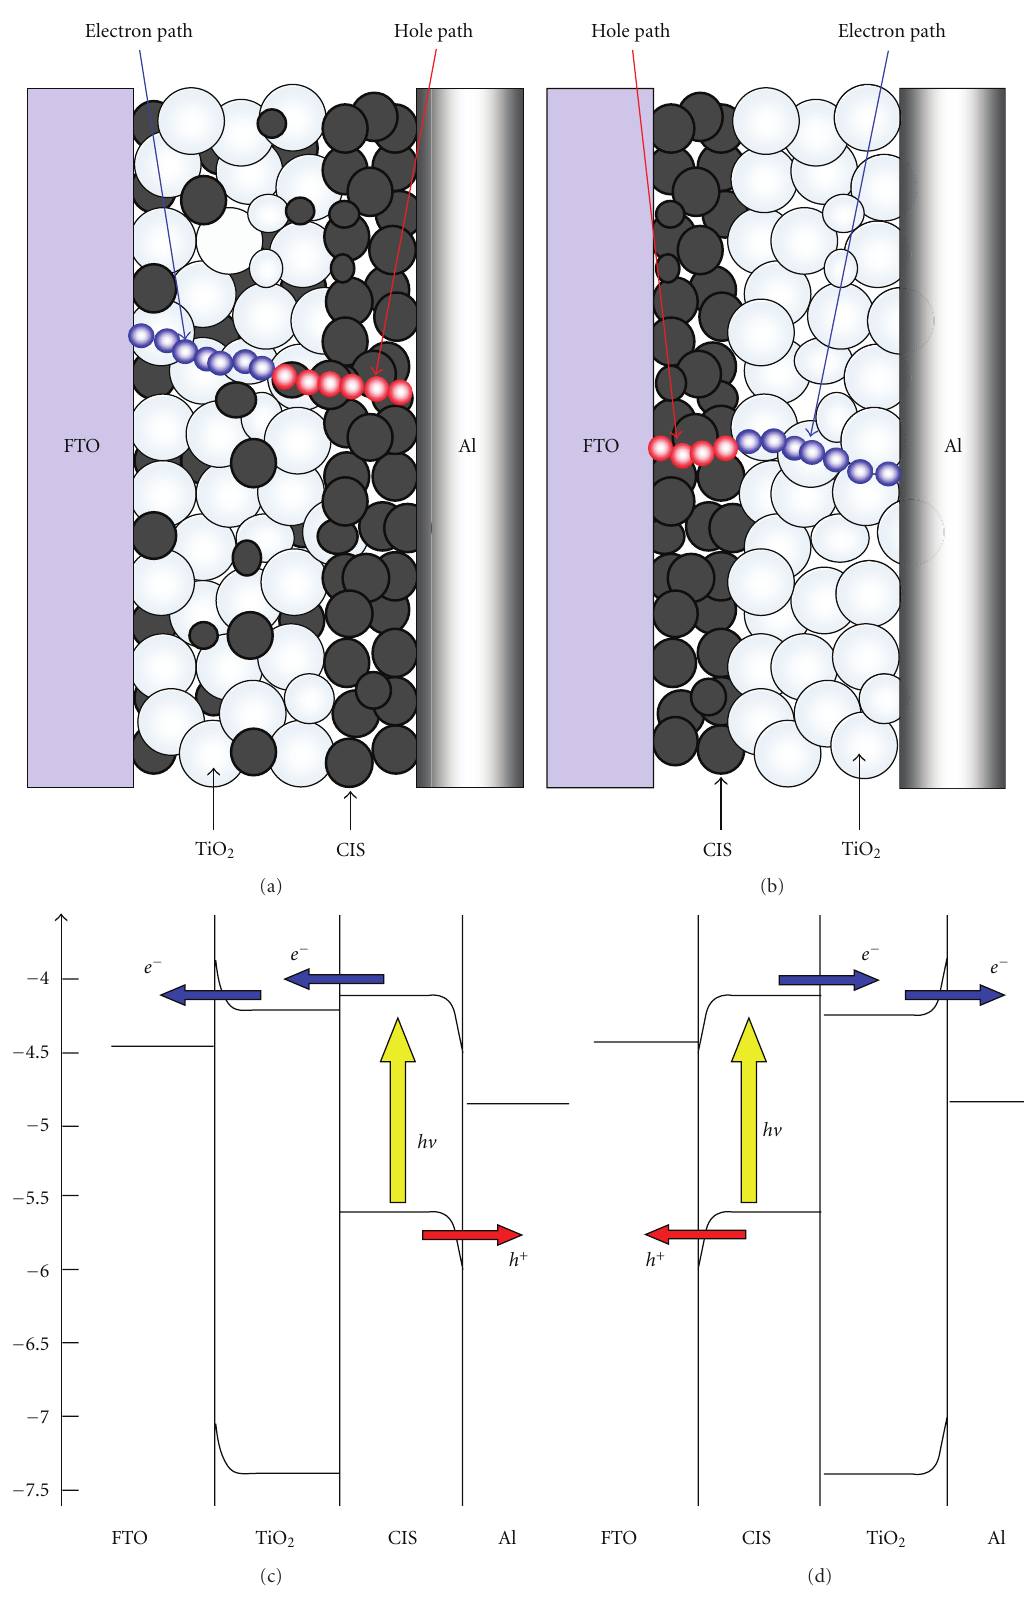
Figure 5: Schematic microstructures of (a) FTO/TiO 2 /CIS/Al and (b) FTO/CIS/TiO 2 /Al solar cells. Energy level diagrams of (a) TiO 2 /CIS and (b) CIS/TiO 2 heterojunction solar